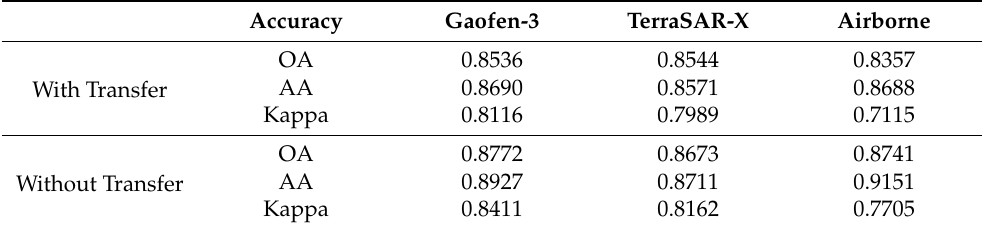
Table 12. Comparison of the performance with or without transfer model from the F-SAR image.